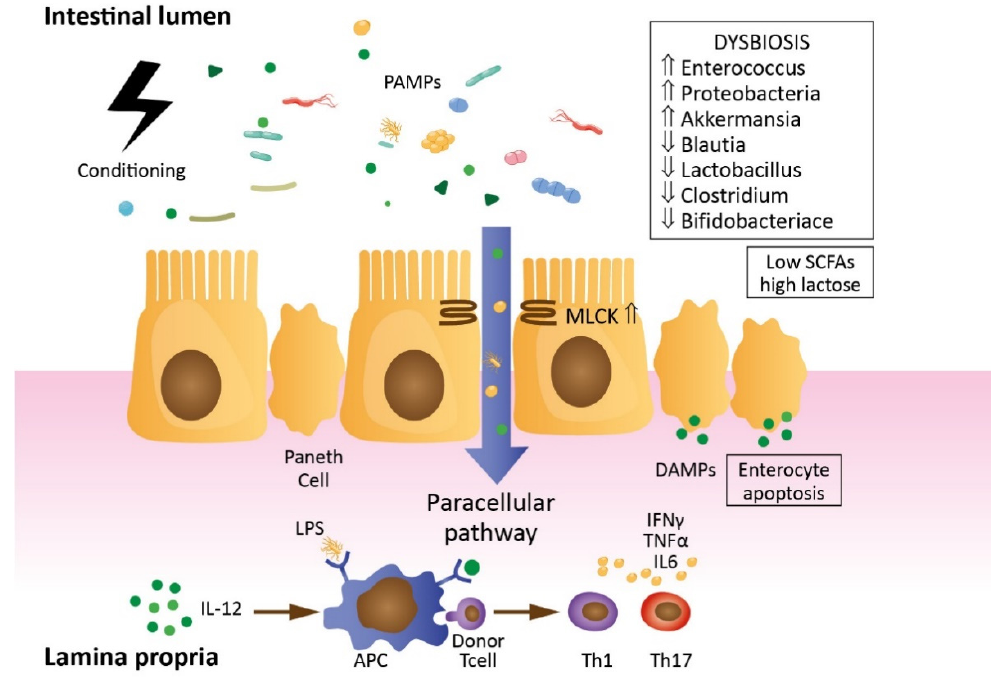
Figure 2. Intestinal barrier disruption after allo-HCT. Pretransplant conditioning results in enterocyte and Paneth cells apoptosis, leading to lower lactase and higher lactose concentrations and dysbiosis with the Enterococcus genus domination associated with lower SCFA concentrations. An increased MLCK expression results in loosening of the tight junctions and PAMPs translocation into the lamina propria. PAMPs (e.g., LPS) and DAMPs from damaged cells activate APCs. It results in donor T-cell activation, proinflammatory cytokines, i.e., IFN- γ , TNF- α , IL-5 release and GVHD. SCFAs, short-chain fatty acids, MLCK, myosin light chain kinase, PAMPs, pathogen-associated molecular patterns, LPS, lipopolysaccharide, DAMPs, damage-associated molecular patterns, APC, antigen-presenting cell, IFN- γ , interferon gamma, TNF- α , tumor necrosis factor alpha, IL-5, interleukin 5 and GVHD, graft-versus-host disease.